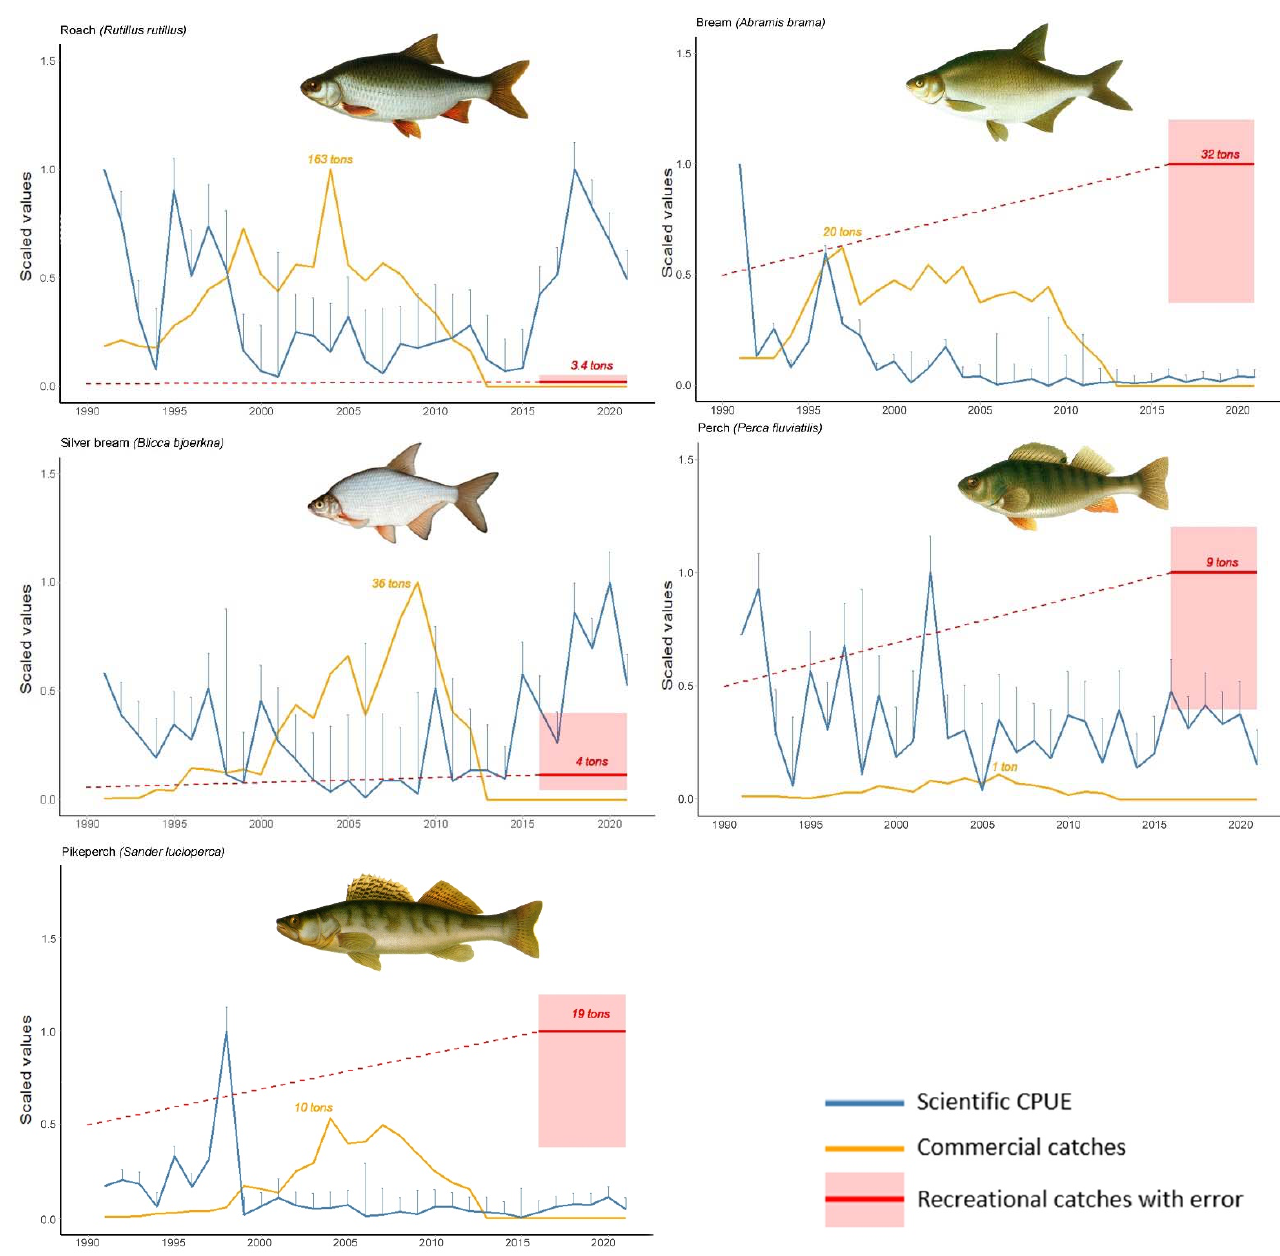
Figure 2. Scaled scientific catch-per-unit-effort (CPUE, model standardized annual deviations based on biomass) and commercial and recreational catches (tons) for the five main fish species in Kaunas Reservoir. Scientific CPUE show standardized annual values and confidence ranges. Recreational catches were estimated for the last 5 years, and show mean estimates and uncertainty ranges. For years since 2016, we provide just an indicative trendline, assuming that recreational effort and, therefore, catches were about half as intense in 1990 and have been steadily growing since then. Note that the y-axis shows relative values, where scientific CPUE was scaled separately, but commercial and recreational catches were scaled together, so they can be compared. The uncertainty ranges for scientific CPUE are symmetrical (up and down), but only upper ranges are plotted because lower ranges are bound by zero (original analysis is performed in a log-transformed space). Absolute commercial fishing values are shown in Figure S1, and estimates for recreational fishing are shown